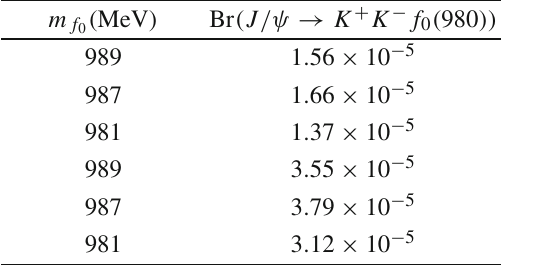
Fig. 4 Triangle amplitude t T , defined in Eq. (17), as a function of M inv ( K − f 0 / K − a 0 ) for a m f = 987 MeV, d m c m f 0 ( a 0 )